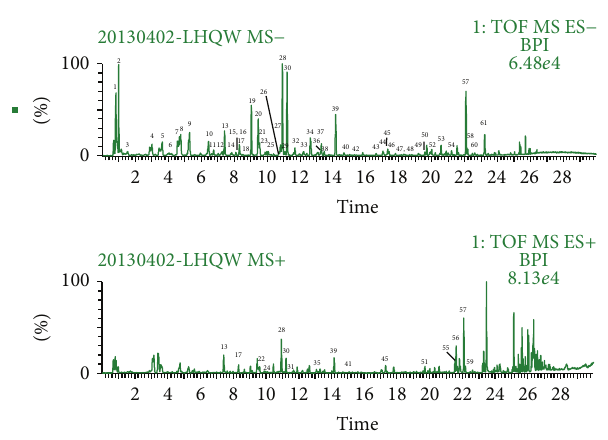
Figure 2: UPLC-QTOF-MS chromatograms of sample solution from negative ion mode and positive ion